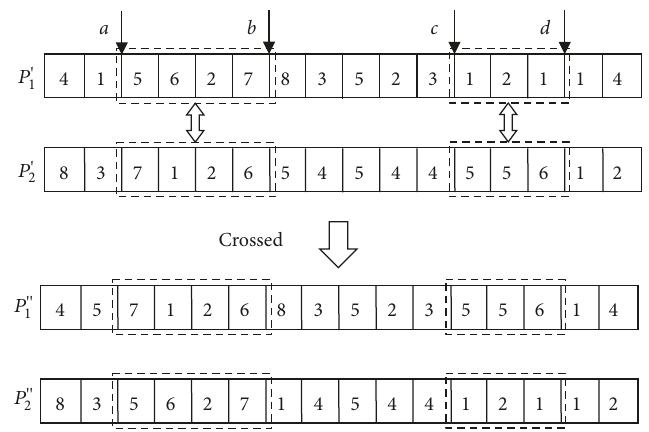
Figure 10: Partially mapped crossover and two-point crossover ( 𝑎 = 3 , 𝑏 = 6 , 𝑐 = 12 , and 𝑑 = 14 ).